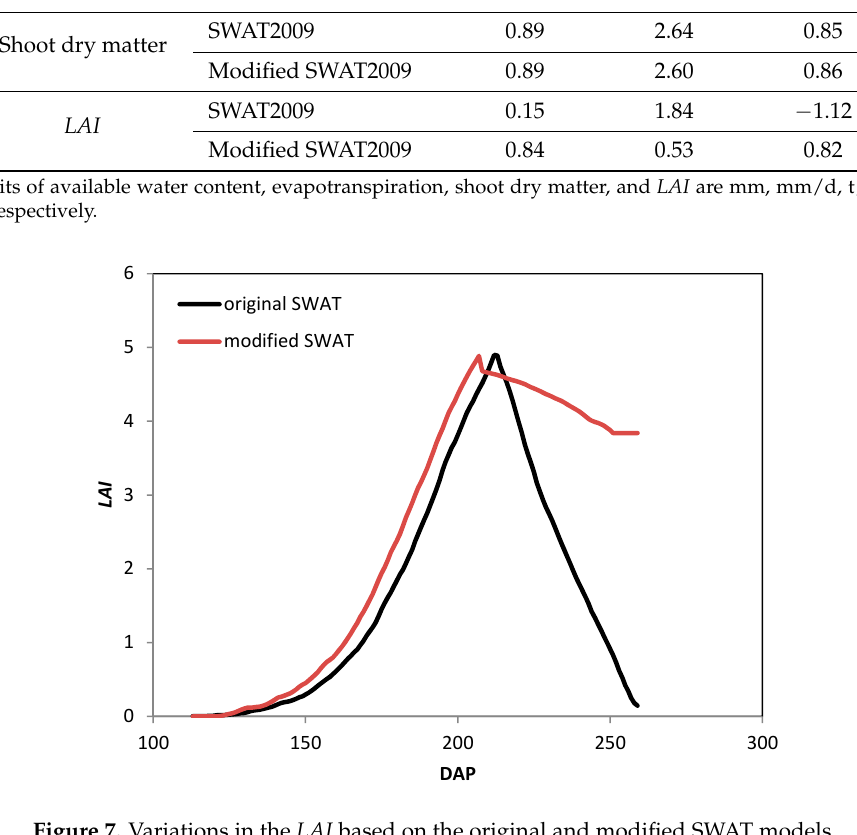
Figure 7. Variations in the LAI based on the original and modified SWAT models.